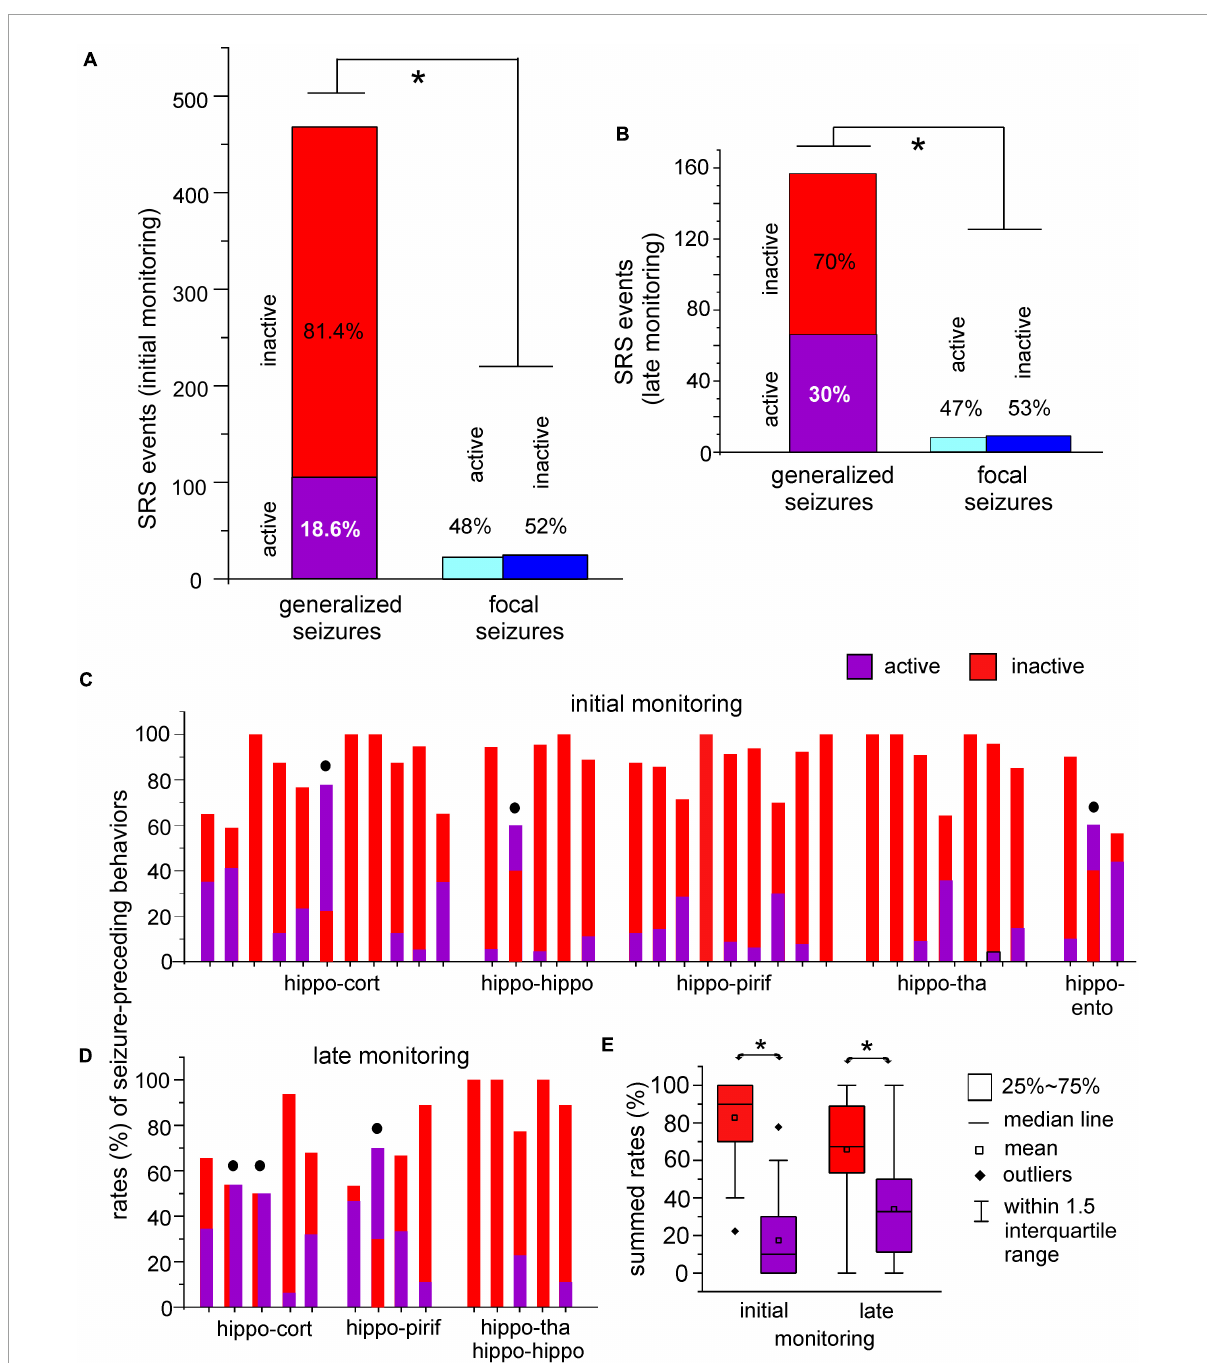
FIGURE5 Seizure-preceding behavioral activities. (A,B) Spontaneous recurrent seizures (SRS) were observed within 10 days (initial monitoring period) and 6–12 weeks (late monitoring period) after termination of kindling stimulation. Data were collected from the five groups of mice. Inactive or active behaviors in a 3 min period prior to seizure onset were analysed. Spontaneous motor seizures were grouped as generalized (stage 3–5) and focal (stage 1–2) events. Seizure-preceding inactive and active behaviors were normalized as percentiles of total generalized or focal events analyzed. Rates of seizure-preceding inactive and active behaviors were significantly different between generalized and focal seizures (* p < 0.001 or p = 0.014, chi-square test). (C,D) Rates of active and inactive behaviors preceding generalized seizures in individual mice. Filled circles denoted mice with equal or greater rates of active relative to inactive behaviors. (E) Box plots showing summed rates of active and inactive seizure-preceding behaviors in initial and late monitoring periods. Rate of inactive behaviors were significantly greater than those of active behaviors (* p < 0.001 or p =